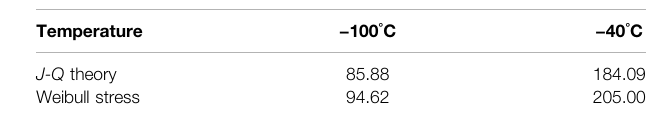
TABLE 2 | Estimated scale parameter K 0 by two approaches (MPa